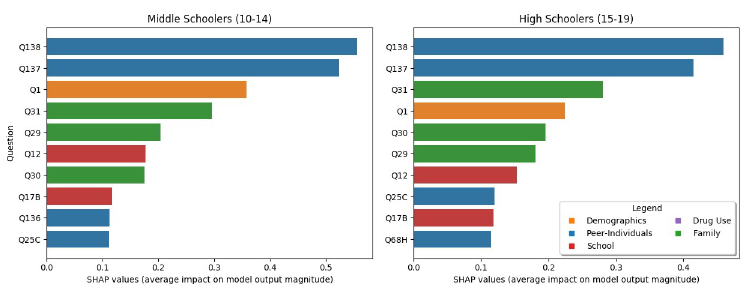
Fig 8. The top 10 most important questions for middle and high school respondents. Note that compared to Fig 3 the majority are the same, however, there are a few slight differences such as the addition of Q17B to both and the addition of Q126 to middle schoolers.